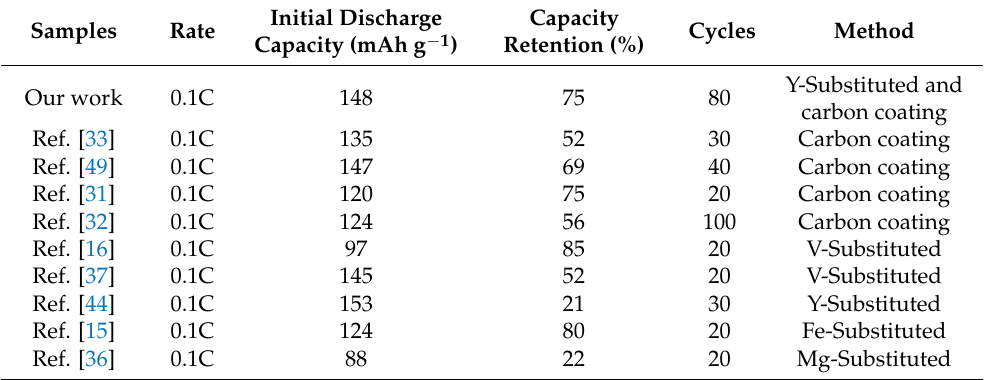
Table 3. Cycling performance of the LiCo 0.97 Y 0.02 PO 4 /C electrode in comparison with others reported.